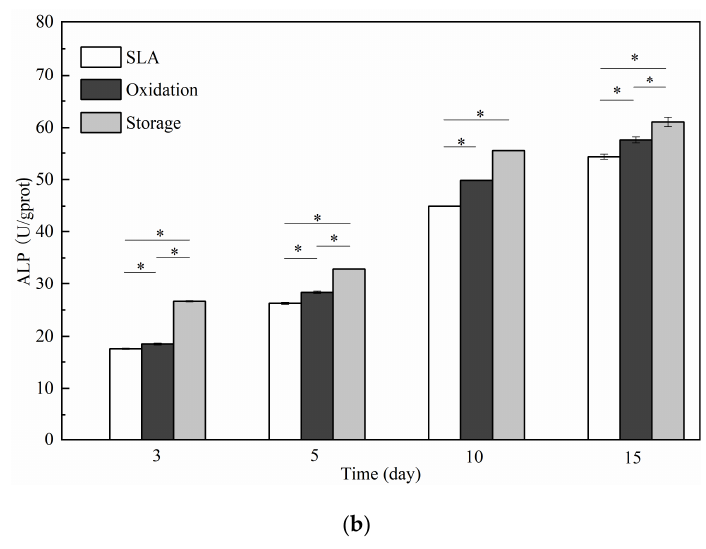
Figure 6. ( a ) OD values of the three groups of samples (x ± s , n = 3, * indicates P < 0.05 among groups); ( b ) ALP activity in the three groups of samples (x ± s , n = 3, * indicates P < 0.05 among groups).